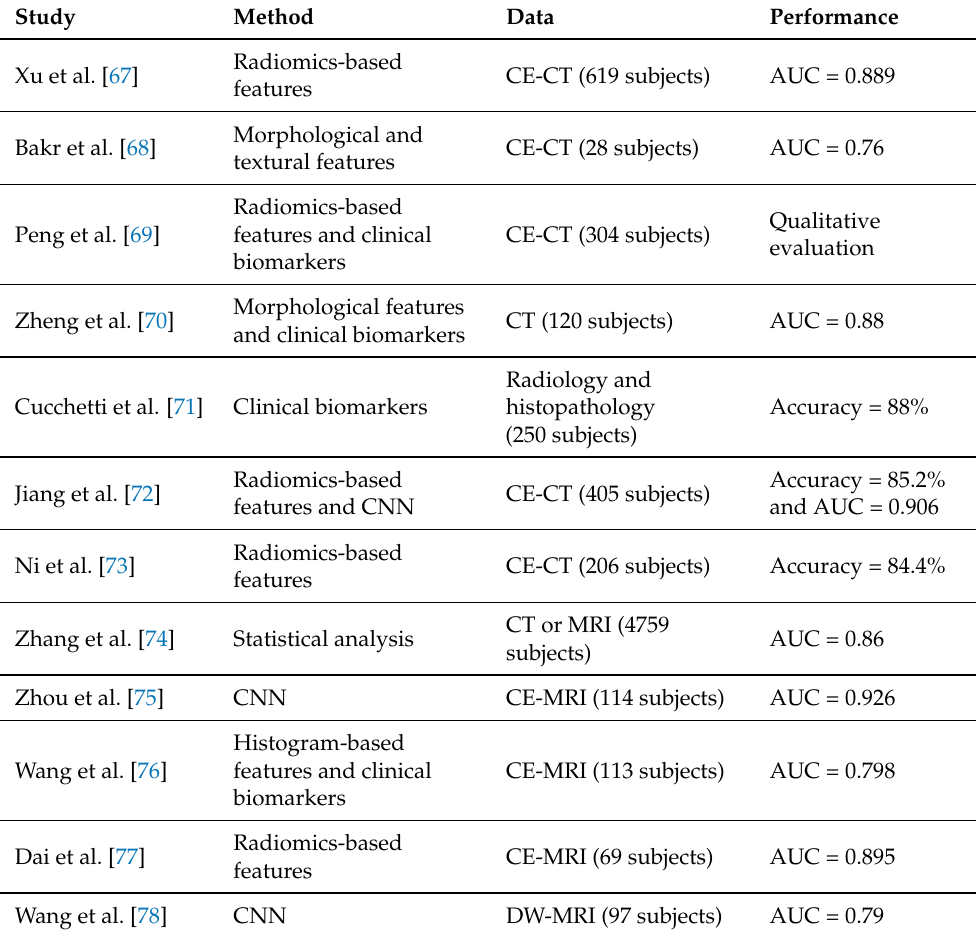
Table 3. Prediction of microvascular